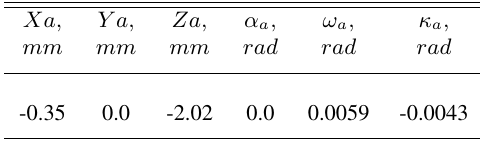
Table 4. Results of rotation axis calibration